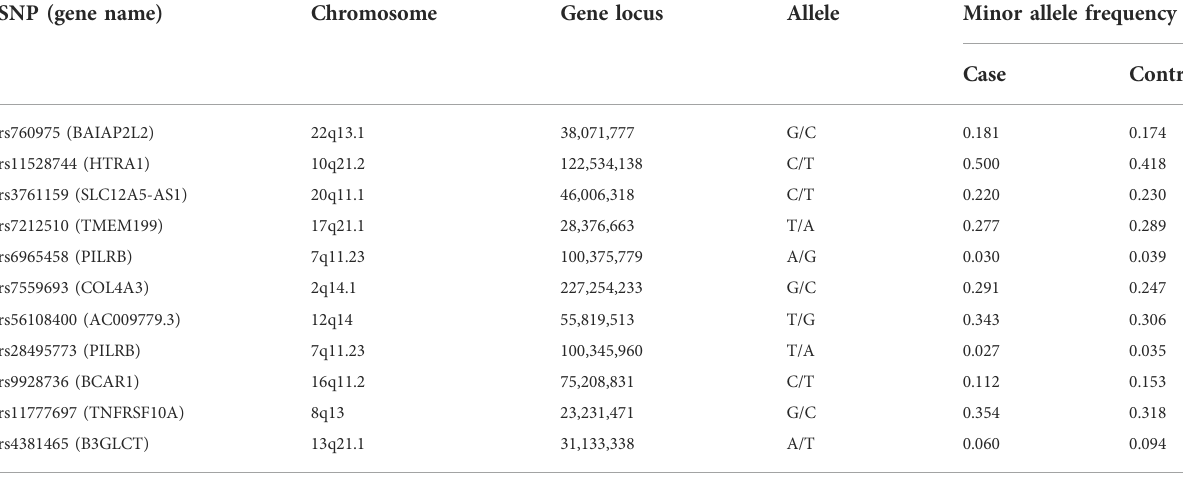
TABLE 2 Basic information and allele frequencies of the 11 selected